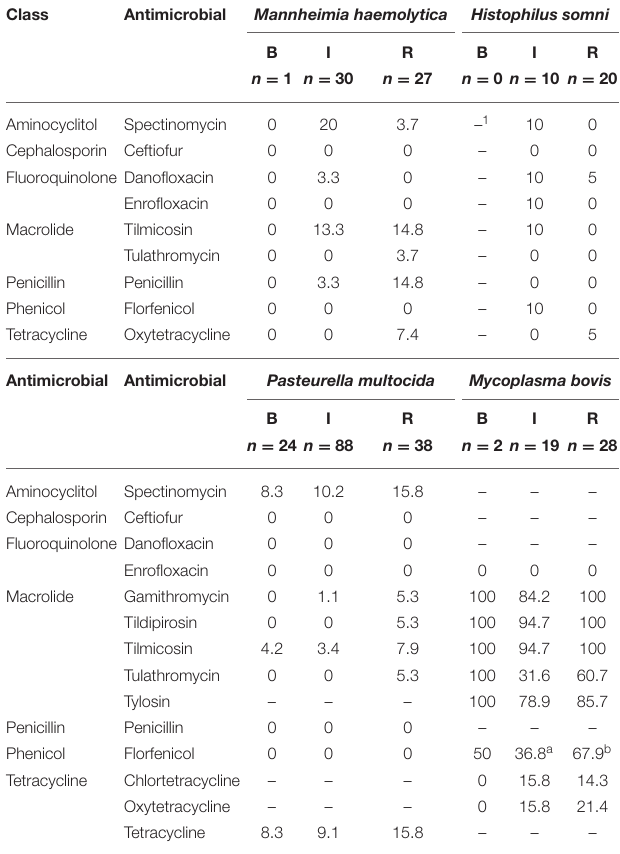
TABLE 4 | Antimicrobial resistance rates (%) according to antimicrobial, sampling point (B, BRANDING; I, WEANING/INDUCTION; R, REPROCESSING), and bacteria species.